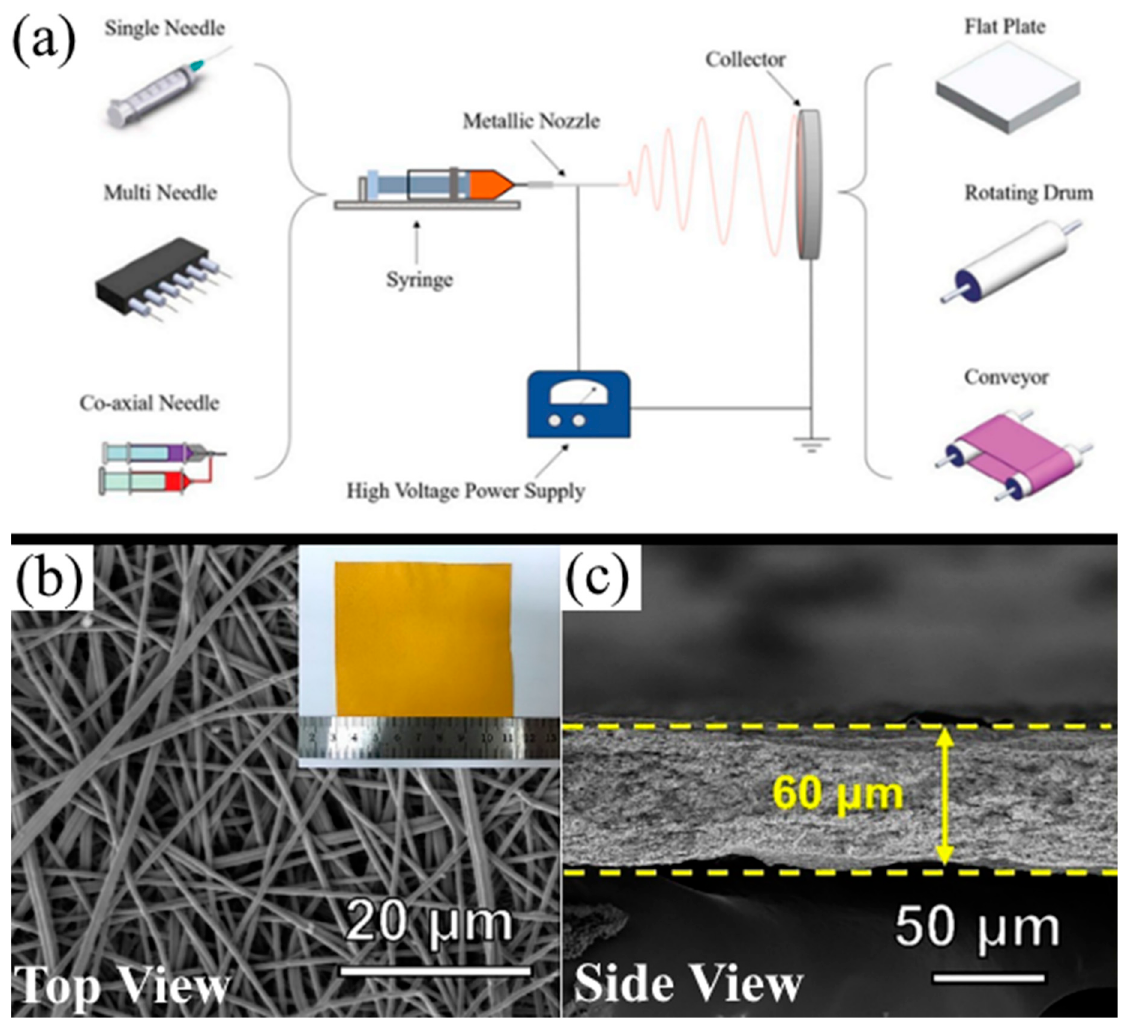
Figure 3. ( a ) A schematic diagram of a standard electrospinning process. Reprinted/adapted with